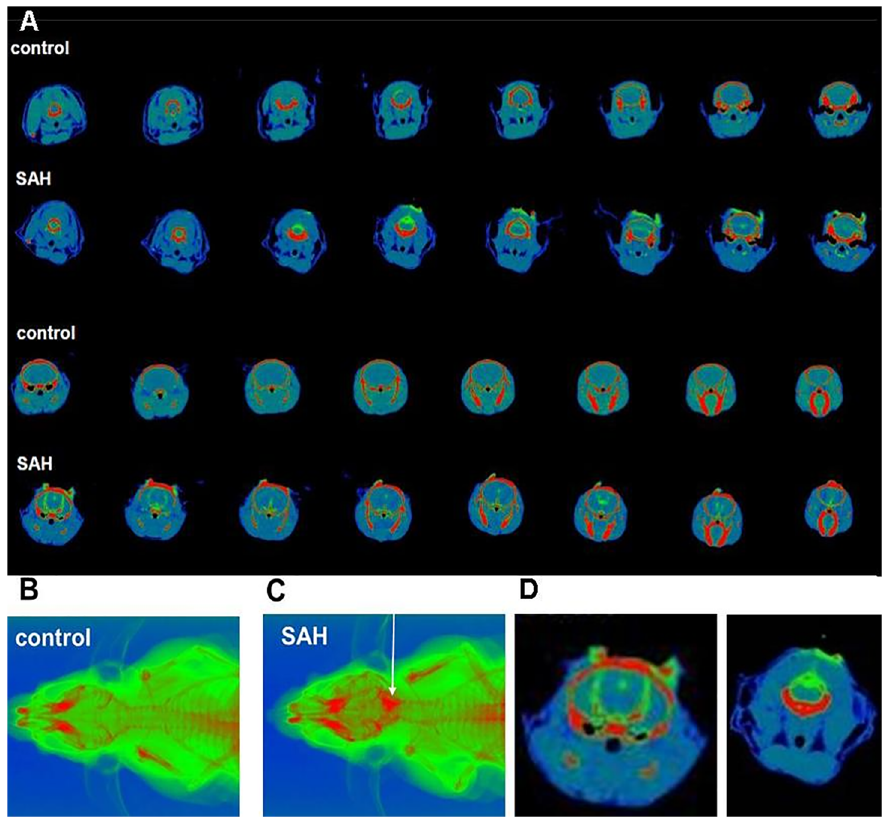
Fig. 1. Micro CT and X-Ray imaging of cisterna magna injection. A: micro CT images (HU range 2 200 to 1200) collected before (control) and immediately after injection of a 1:1 mixture of blood and the contrast agent Imerone 400 (SAH). The contrast agent is visible in the subarachnoid space and in the entire ventricular system. B: X-ray of before blood-Imerone 400 injection (control). C: X-ray collected immediately after blood- Imerone 400 injection into the cisterna magna. Note the high concentration of contrast agent in the area corresponding to the basal cistern but also quick dispersion into more cranially located regions. D: two exemplary micro images of the SAH group with a high